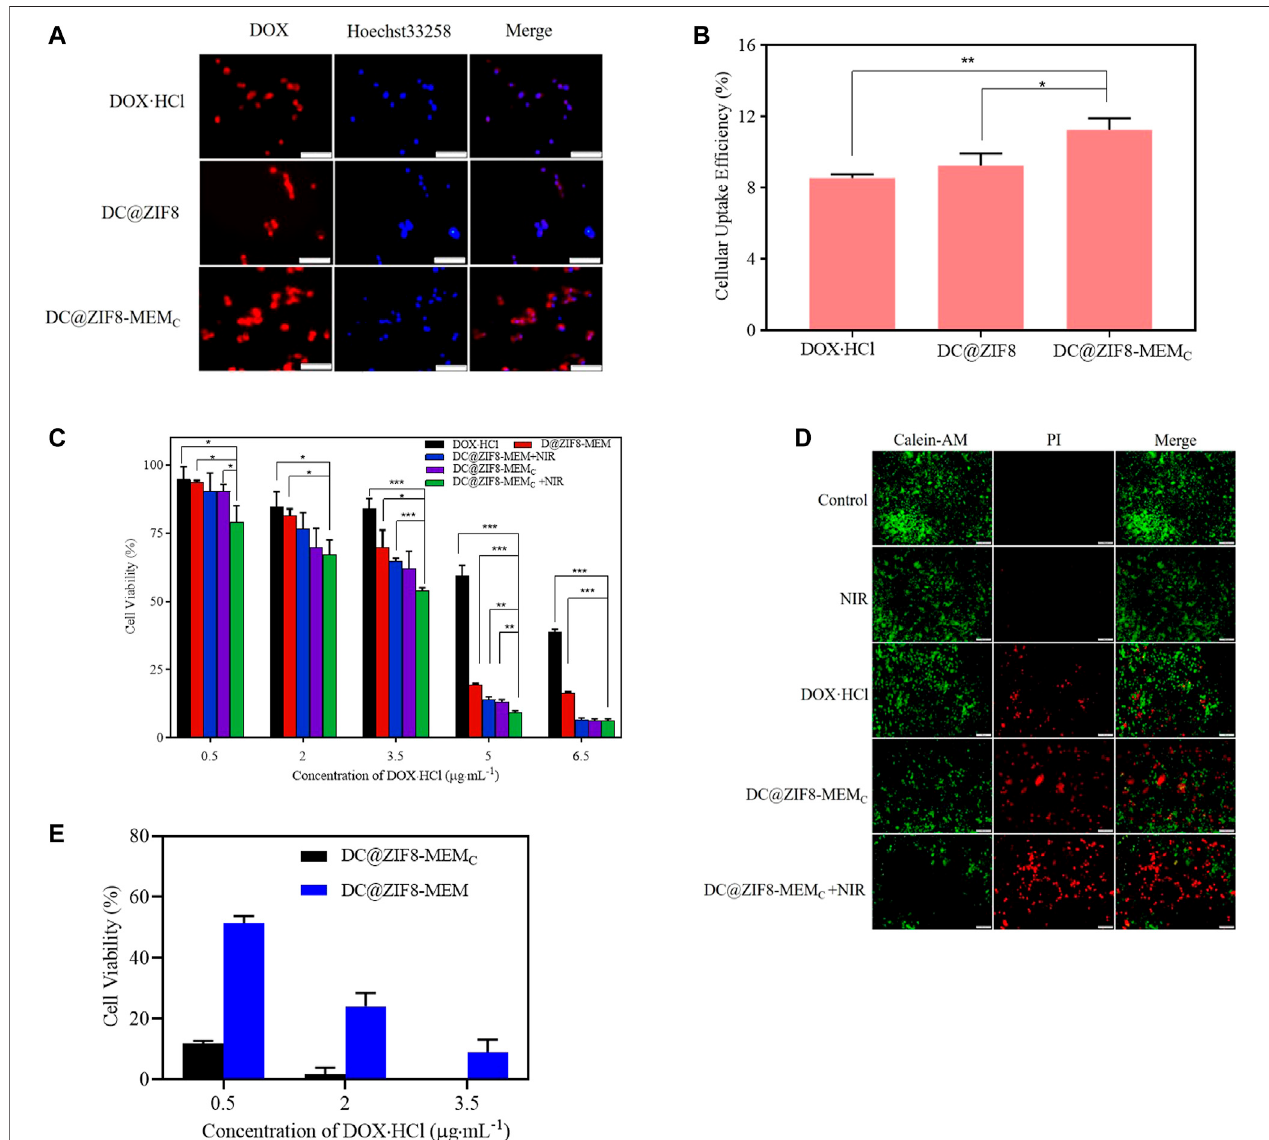
FIGURE 4| Fluorescence images of mouse breast cancer cells (4T1) incubated with different samples for 4 h, scale bar = 100 µm (A) . Cellular uptake ef fi ciency of different samples to 4T1 cells by microplate reader (B) . Cytotoxicity of 4T1 cells incubated with different samples at various concentrations for 24 h (C) . Labeling of live and dead cells by calcein AM/propidium iodide (PI) for different samples; scale bar = 200 μ m (D) . Cytotoxicity of 4T1 cells incubated with different samples at various concentrations in hypoxia incubator for 24 h (E) . * p < 0.05, ** p < 0.01, *** p < 0.001.